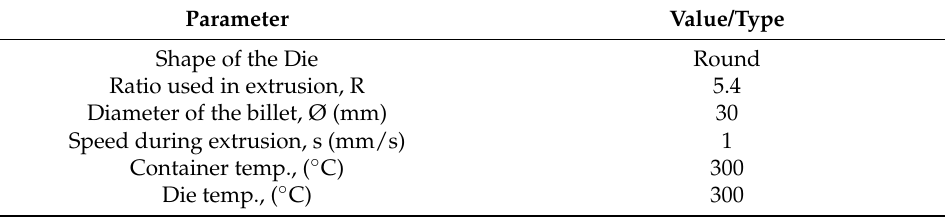
Table 1. Factors used in conducting the hot extrusion.